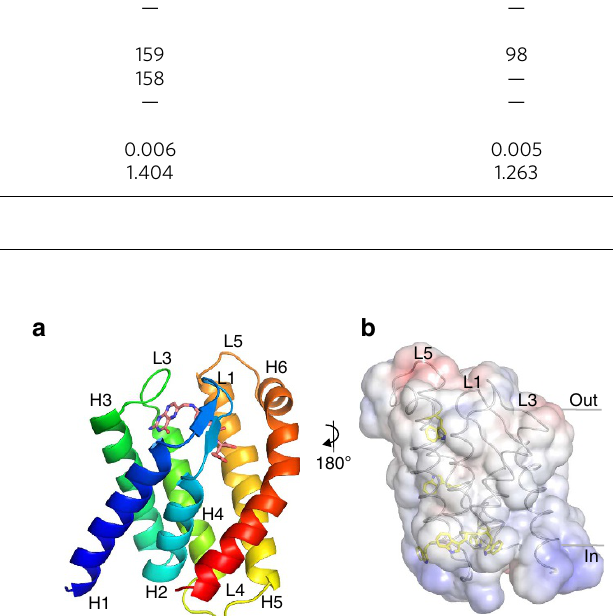
Figure 1 | Crystal structure of folate-bound FolT1. ( a ) Cartoon representation of FolT1 coloured from blue (N terminus) to red (C terminus), with folate shown in stick representation. H1-6 indicates a -helices 1-6. The carbon atoms of folate are shown in deep salmon, the oxygen and nitrogen atoms are shown in red and blue, respectively. The colour coding for oxygen and nitrogen atoms remained throughout the article. The membrane orientation was derived from the hydrophobicity of the surface, the positive inside rule and the location of aromatic residues shown in b , in which the transparent surface is coloured according to the surface electrostatic potential (negative potential in red and positive potential in blue), and tryptophan residues are shown in sticks with their carbon atoms coloured yellow. The bottom of the protein faces the cytoplasm, while the top faces the extracellular side of the